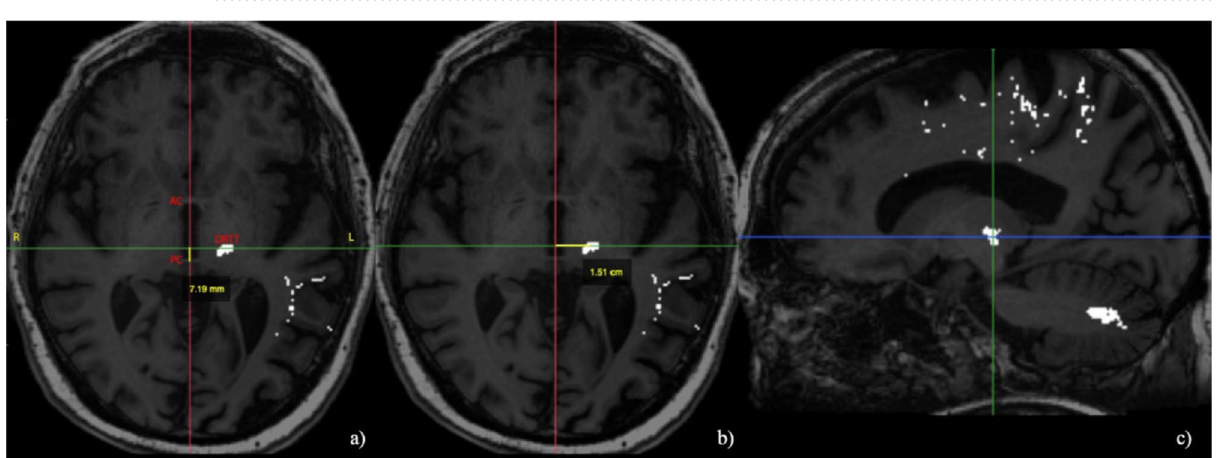
Figure 3. Direct AP ( a ), RL ( b ) and SI ( c ) coordinates manual measurement on multiplanar 2D reconstruction of the